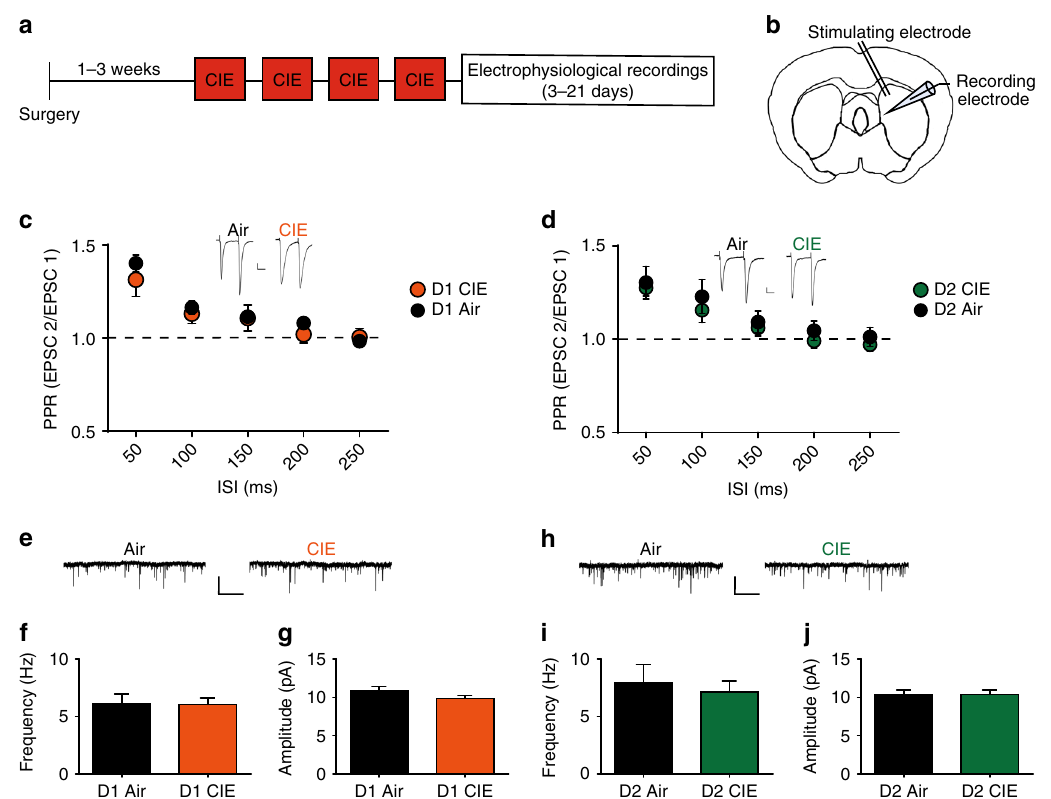
Fig. 3 CIE does not alter all excitatory input into striatal circuits. a Experimental timeline for cohorts of mice used for electrophysiological recordings. Mice were injected with AAV ChR2 in the OFC and allowed 2 – 4 weeks to recover before exposure to the CIE procedure. Data collected in which currents were evoked electrically were done in the same brain slices used for optically evoked currents. b Schematic of DMS recording site and placement of stimulating electrode within striatum. c , d Paired pulse ratio (PPR) of electrically induced currents onto D1 SPNs (Air n = 6, CIE n = 6) ( c ) and D2 SPNS (Air n = 7, CIE n = 11) ( d ) in Air or CIE-exposed mice. Scale bars represent 25 ms (horizontal) and 50 pA (vertical). e Representative traces of spontaneous EPSCs (sEPSCs) in D1 SPNs in Air and CIE mice. Scale bars represent 1 s (horizontal) and 20 pA (vertical). f , d Frequency ( f ) and amplitude ( g ) of sEPSCs in D1 SPNs from Air and CIE mice. h Representative traces of spontaneous EPSCs (sEPSCs) in D2 SPNs in Air and CIE mice. i , j Frequency ( i ) and amplitude ( j ) of sEPSCs in D2 SPNs from Air and CIE mice. Data points and bar graphs represent the average ± ( p s > 0.05), D1 SPNs main effect of ISI: F (4, 40) = 37.69, p < 0.0001;